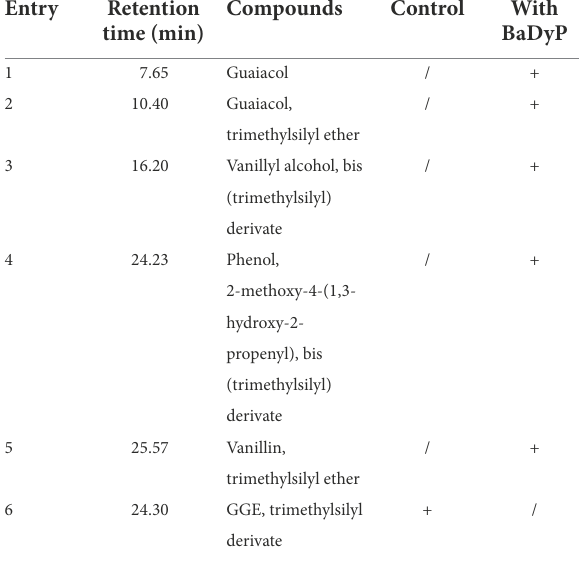
TABLE 1 GGE and its degradation derivatives identified by GC–MS.